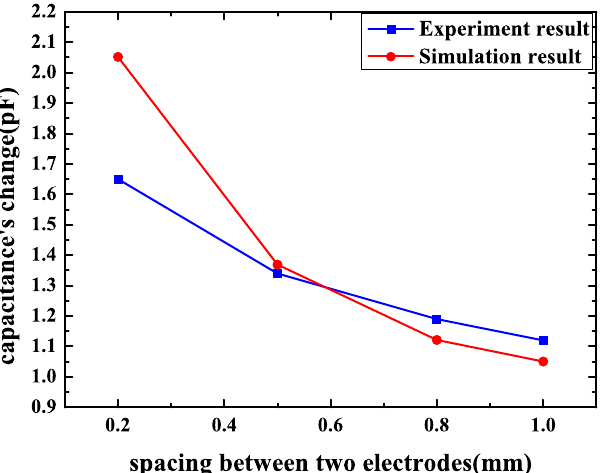
Figure 14. Experimental results of a spiral pattern sensor capacitance’s change with electrodes’